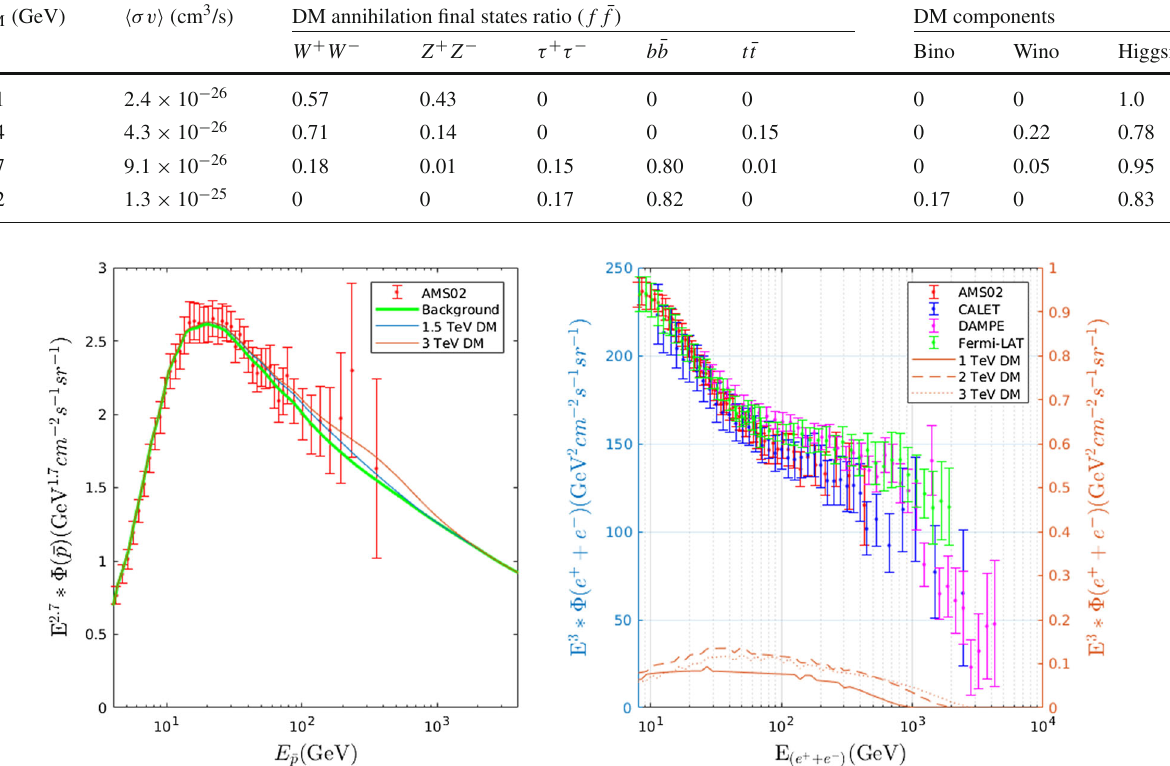
Fig. 5 The antiproton flux (left panel) and electron plus positron flux (right panel). For the antiproton flux, the AMS-02 data [30] and its fit- ted curve as well as the results with the 1.5 TeV neutralino dark matter annihilation contribution are shown. For the electron plus positron flux,